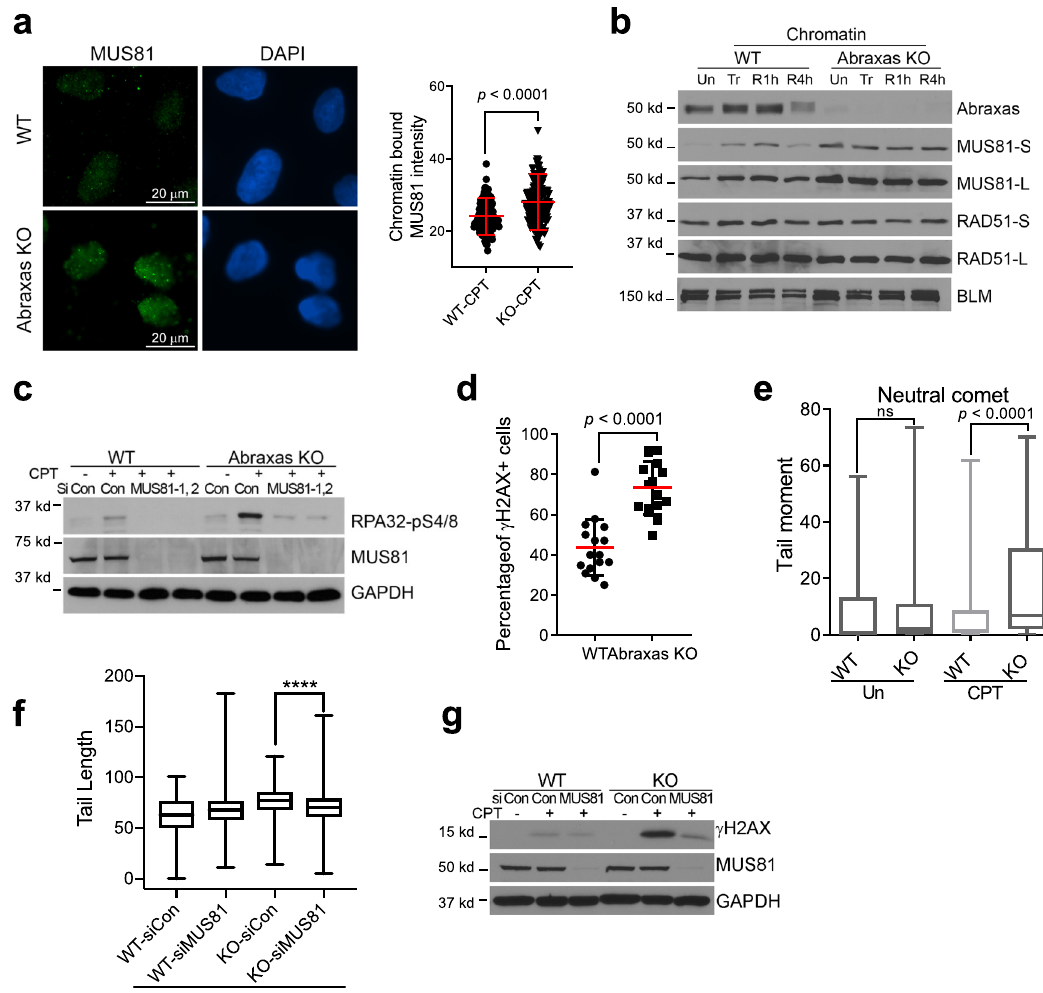
Fig. 3 MUS81 overloading on chromatin in Abraxas-de fi cient cells leads to increased resection. a Increased chromatin-bound MUS81 in Abraxas KO cells detected by immuno fl uorescence. Cells upon CPT treatment were pre-extracted with 0.2% Triton X-100 before fi xation and stained with MUS81 antibody. Representative images of MUS81 staining (left panel) and quanti fi cation of MUS81 nuclear intensity measured by ImageJ (right panel) are shown as mean value ± SD for WT-CPT ( n = 142), KO-CPT ( n = 168) cells examined. Two-tailed Student ’ s t -test was used for statistical analysis. b Increased chromatin-bound MUS81 in Abraxas KO cells detected by cell fractionation and western blotting. Chromatin fraction of cells untreated (Un), treated with 1 μ M CPT for 1 h (Tr), or released into fresh medium for 1 h (R1h) or 4 h (R4h) after treatment were prepared for western blottings. c Elevated RPA32-pS4/ 8 levels in Abraxas KO cells upon CPT treatment was reduced by MUS81 knockdown. Cells transfected with siRNAs were untreated or treated with 1 μ M CPT for 1 h. d Quanti fi cation of γ H2AX immuno fl uorescence staining in WT and Abraxas KO U2OS cells treated with CPT (1 μ M, 1 h). Percentage of cells containing more than 10 γ H2AX foci was quanti fi ed as mean value ± SD for WT ( n = 16 independent image areas with total 319 cells) and KO ( n = 16 independent image areas with total 401 cells). Two-tailed t -test was used for statistical analysis. e Increased DSBs in Abraxas KO cells treated with CPT (1 μ M, 1 h) as detected by neutral comet assay. Tail moments were measured by open comet software and plotted as box plot. Center line indicates median, box bounds indicate fi rst and third quartiles, whiskers indicated maximum and minimum for WT-Un ( n = 274), KO-Un ( n = 152), WT-CPT ( n = 383), and KO-CPT ( n = 249) cells examined. One-way ANOVA Kruskal – Wallis test was used for statistical analysis. f MUS81 knockdown reduced DSBs accumulation in Abraxas KO cells upon CPT treatment as detected by neutral comet assay. Tail length was measured by open comet software and plotted as box plot. Center line indicates median, box bounds indicate fi rst and third quartiles, whiskers indicated maximum and minimum for WT- siCon ( n = 161), WT- siMUS81 ( n = 271), KO- siCon ( n = 180), and KO- siMUS81 ( n = 286) cells examined. One-way ANOVA Kruskal – Wallis test was used for statistical analysis. **** p < 0.0001. g MUS81 knockdown reduced γ H2AX levels in Abraxas KO cells upon CPT treatment. Cells transfected with indicated siRNAs were untreated or treated with 1 μ M CPT for 1 h. See also Supplementary Fig.